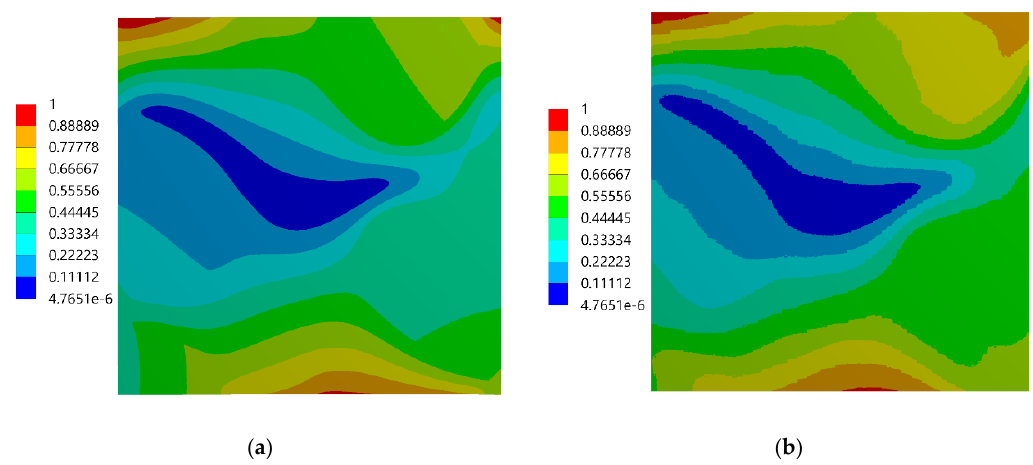
Figure 8. Distribution of the total normalized displacement: ( a ) FE reference solution, ( b ) DIC analysis.